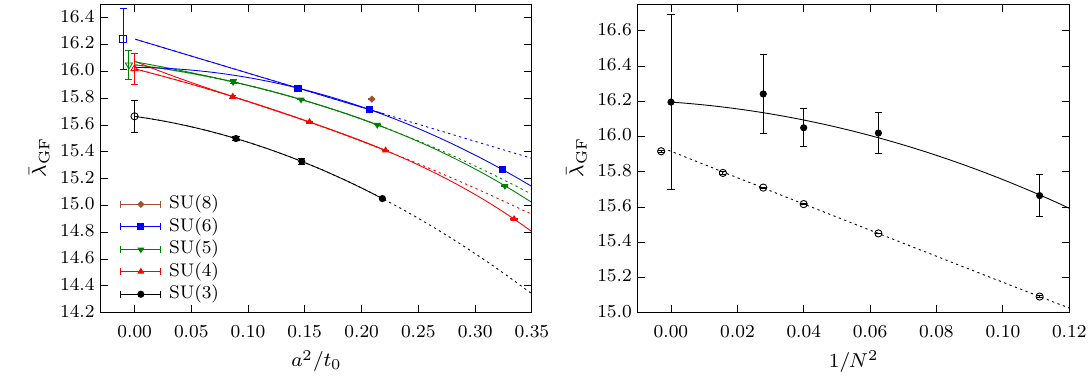
Fig. 11 Left: Continuum extrapolation of ¯ λ GF at t / t 0 = 0 . 2 for all the different gauge groups. Right: Large N extrapolations of ¯ λ GF in the continuum (solid line) and at finite lattice spacing (dotted line). There